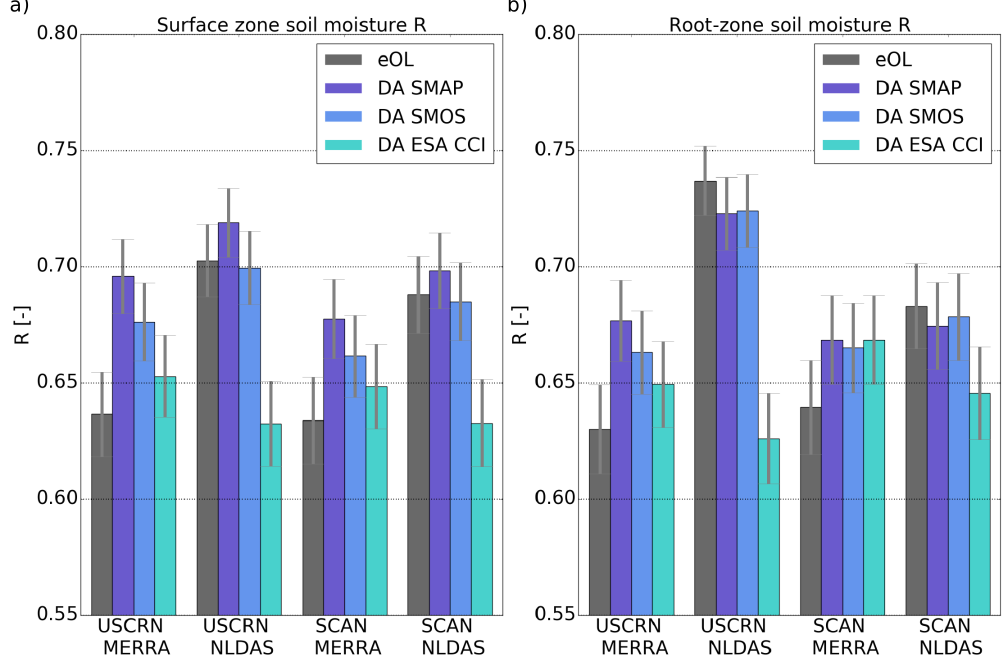
Figure 11. Summary statistics for the assimilation of SMAP (dark blue), SMOS (light blue) and ESA CCI (turquoise), surface and root-zone Pearson R correlation coefficient. Statistics are only computed for stations covered by the ESA CCI product; this is to ensure a fair intercomparison. ( a ) domain average surface zone R, eOL (black), SMAP (dark blue), SMOS (light blue) and ESA CCI (turquoise); ( b ) domain average root-zone